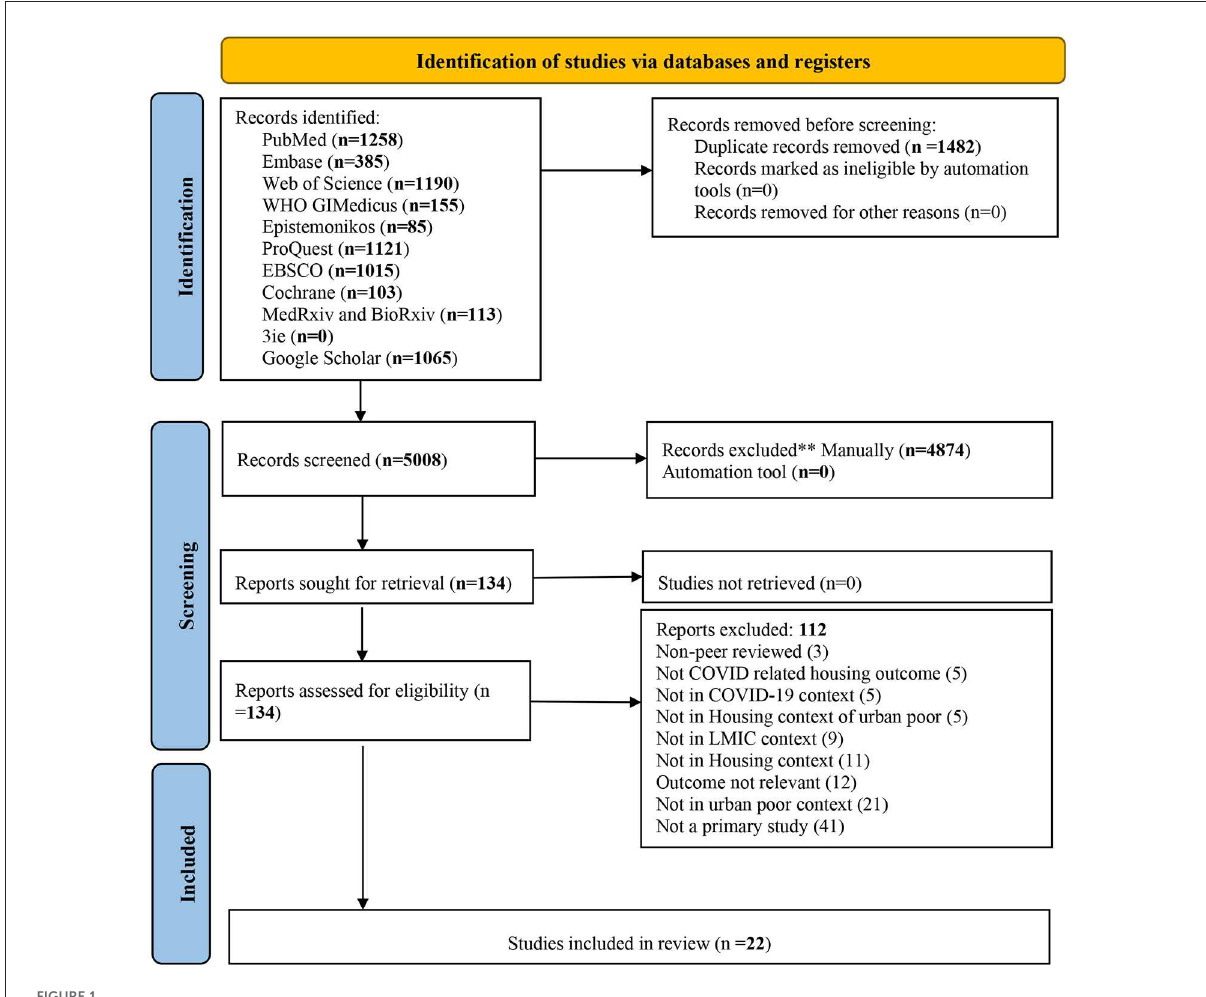
FIGURE1 PRISMA flow diagram